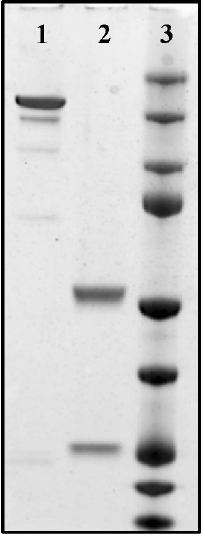
Figure 2. SDS-PAGE. 1: H5K1 not reduced, 2: H5K1 reduced, 3: Marker. Full-length blot is presented in Supplementary Fig. 2